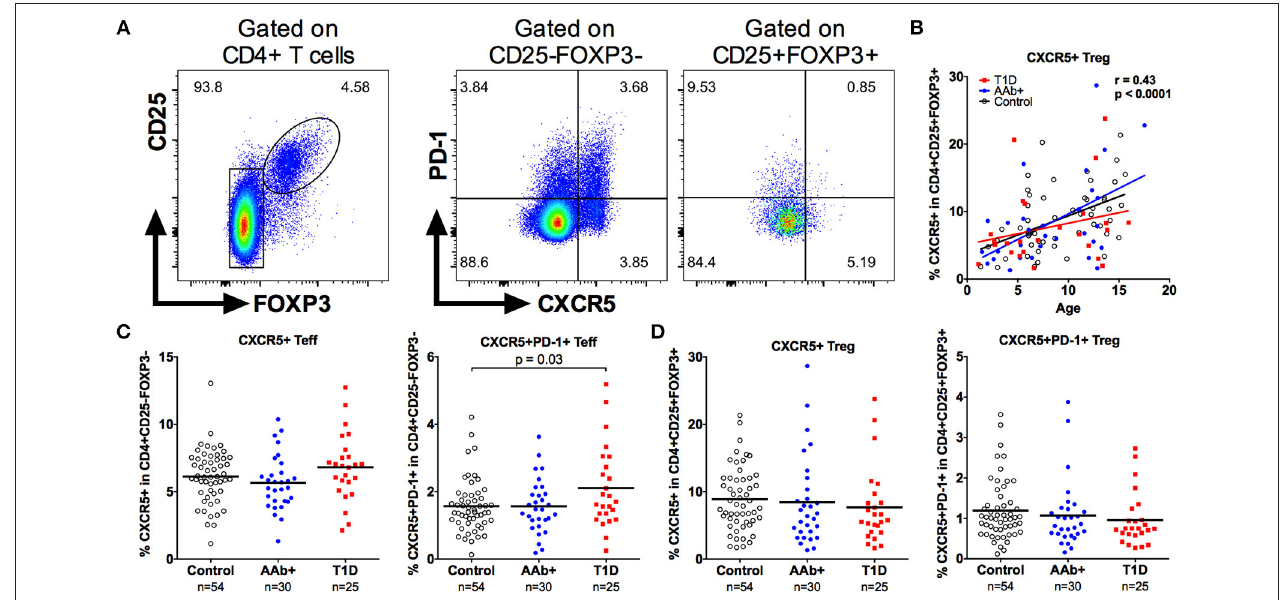
FIGURE 7 | Increased frequency of circulating Tfh but not Tfr cells in children with newly diagnosed T1D. Tfh cells were defined as CD4 + CD25-FOXP3-CXCR5 + and Tfr cells as CD4 + CD25 + FOXP3 + CXCR5 + cells (A) . Linear regression lines for CXCR5 + Treg frequencies against age were calculated for the control (black lines), AAb + (blue lines) and T1D (red lines) groups (B) . Correlation was calculated by pooling all samples analyzed and is expressed together with the P value next to the plot. Frequencies of CXCR5 + and CXCR5 + PD-1 + Teffs (Tfh; C ) and frequencies of CXCR5 + and CXCR5 + PD-1 + Tregs (Tfr; D ) in control, AAb + , and T1D groups.